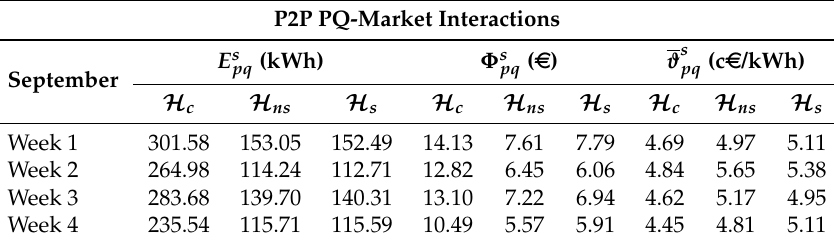
Table 8. P2P power-quota market selling interactions.